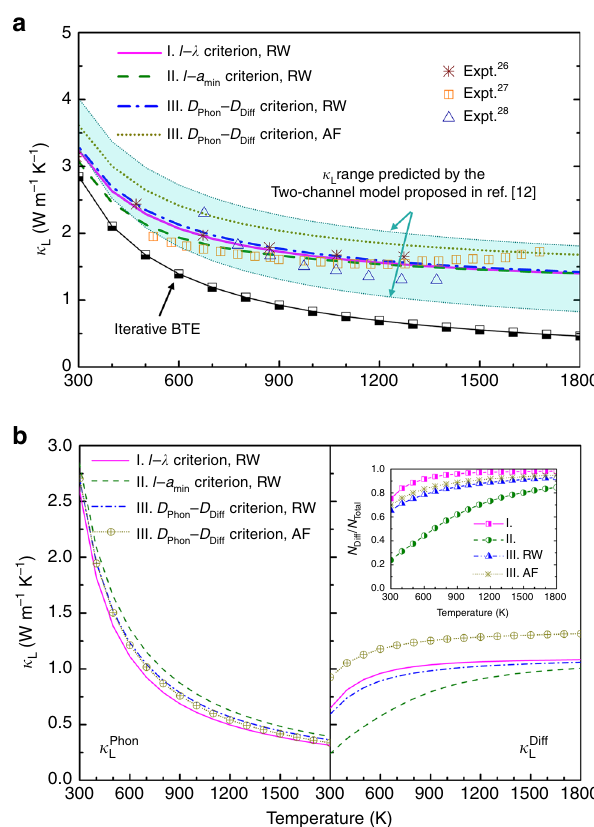
Fig. 4 Lattice thermal conductivity of La 2 Zr 2 O 7 . a The calculated temperature-dependent lattice thermal conductivity ( κ L ) for La 2 Zr 2 O 7 using our dual-phonon theory. The results from the iterative solution of BTE, Mukhopadhyay et al. ’ s two-channel model 12 , and experiments 26 – 28 are presented for comparison. b The contribution to total κ L from normal phonons ( κ Phon ) and diffuson-like phonons ( κ Diff ). Inset: The number of L L diffuson-like phonons ( N Diff ) divided by the number of all vibrational modes ( N Total = N Phon + N Diff ) for La 2 Zr 2 O 7 , calculated as a function of temperature. Source data are provided as a Source data fi